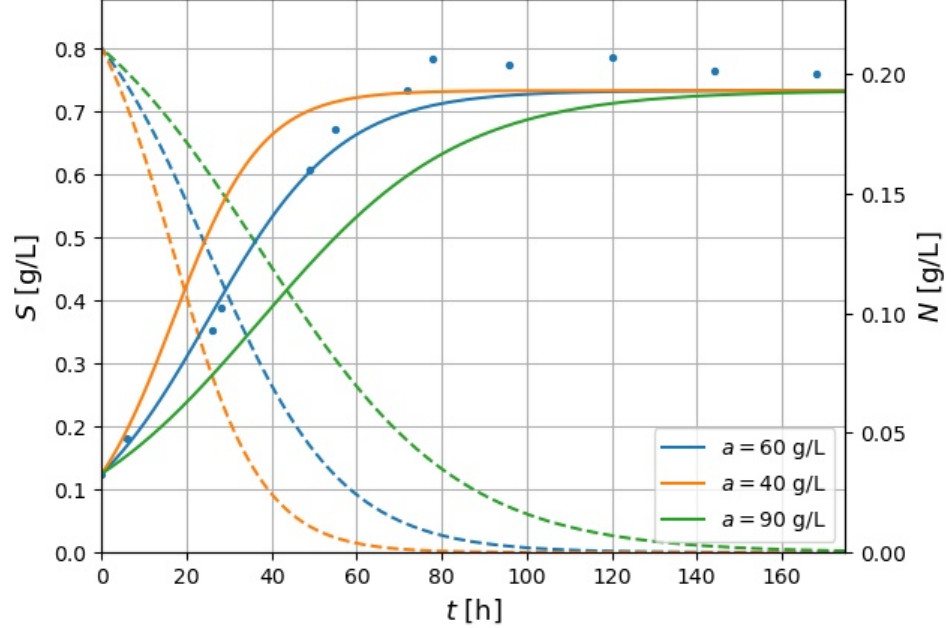
Figure 6. Influence of the maximal growth rate r m on the growth curves ( γ = 0.2 and a = 60 g/L). Blue dots represent experimental data.